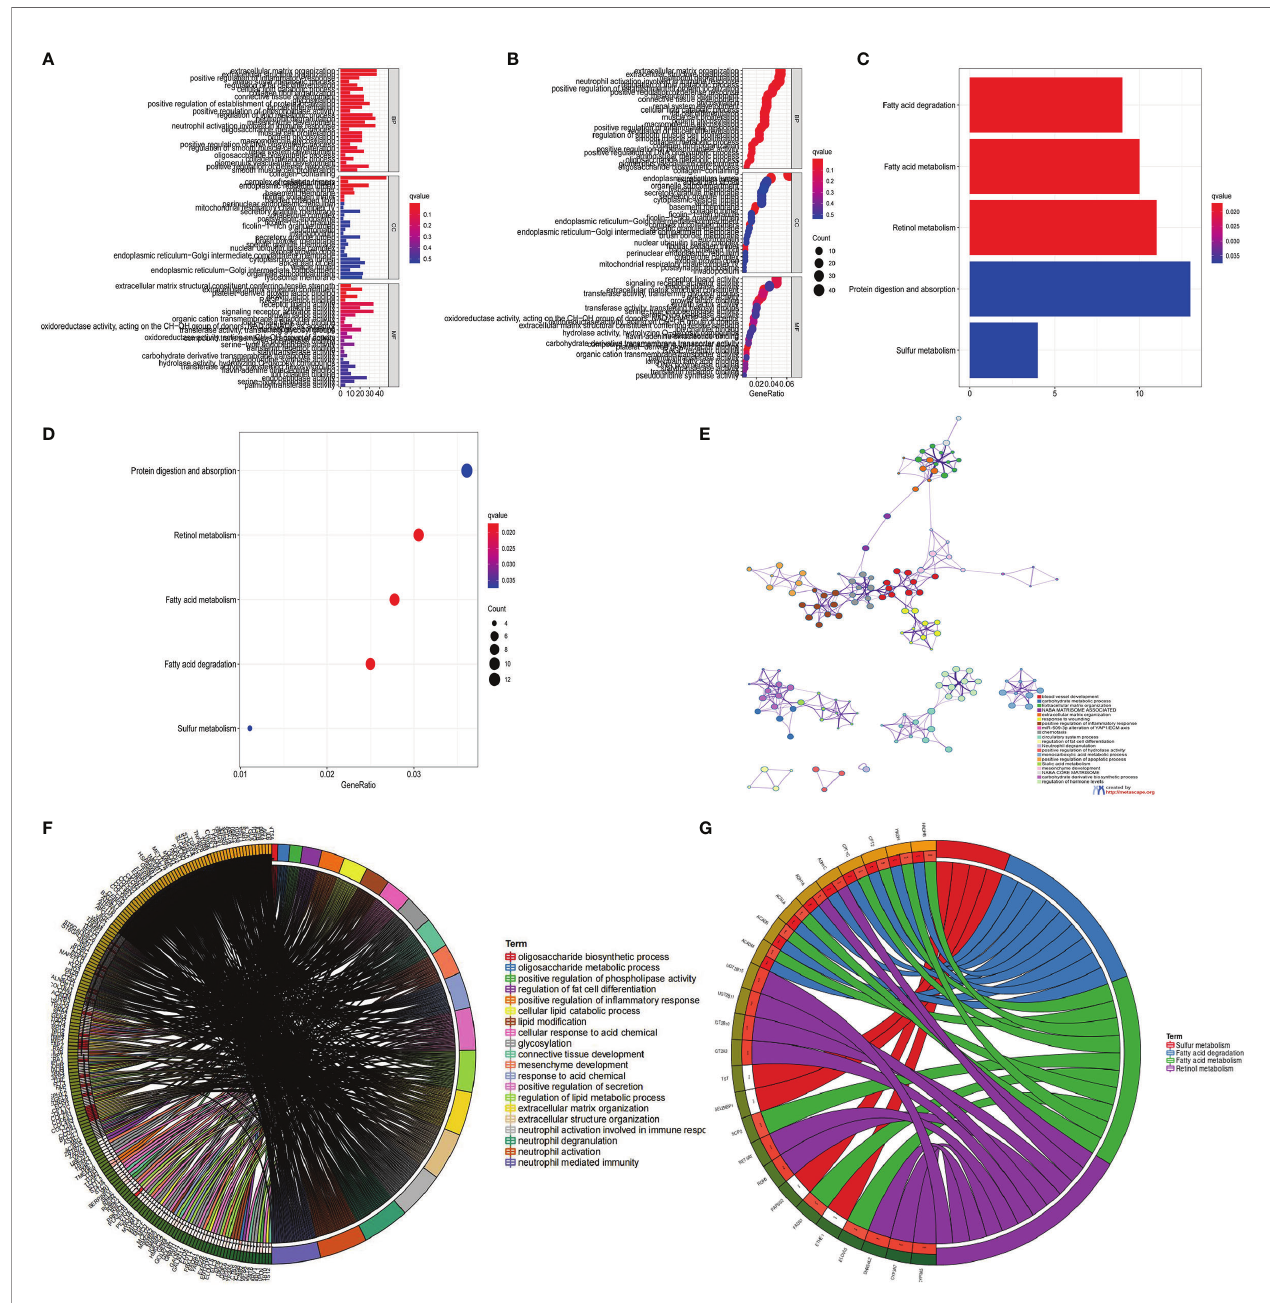
FIGURE 5 | KEGG and GO enrichment analysis of m6A related genes. (A, B) GO enrichment analysis for functional annotation of m 6 A-related genes. The color depth of the histogram represents the number of enriched genes. (C, D) KEGG enrichment analysis for the functional annotation of m 6 A-related genes. The color depth of the histogram represents the number of enriched genes. (E) The interaction of pathways of 23 m6A regulatory factors. The circles of different colors represent different types of pathways and the lines linking them represent their interaction. (F) Circle plot showing the enrichment analysis of various pathways. (G) Circle plot showing the enrichment analysis of different metabolic